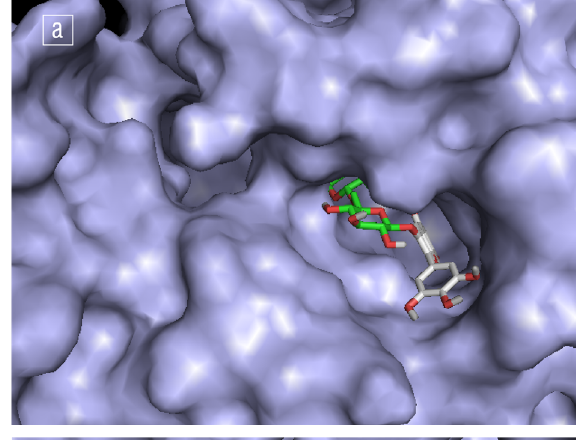
Phytochemical group